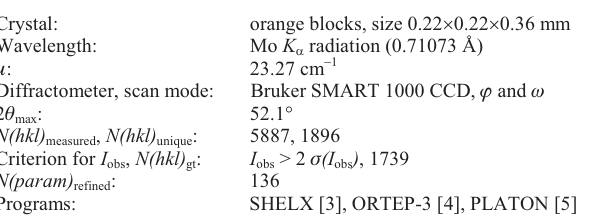
Table 1. Data collection and handling.